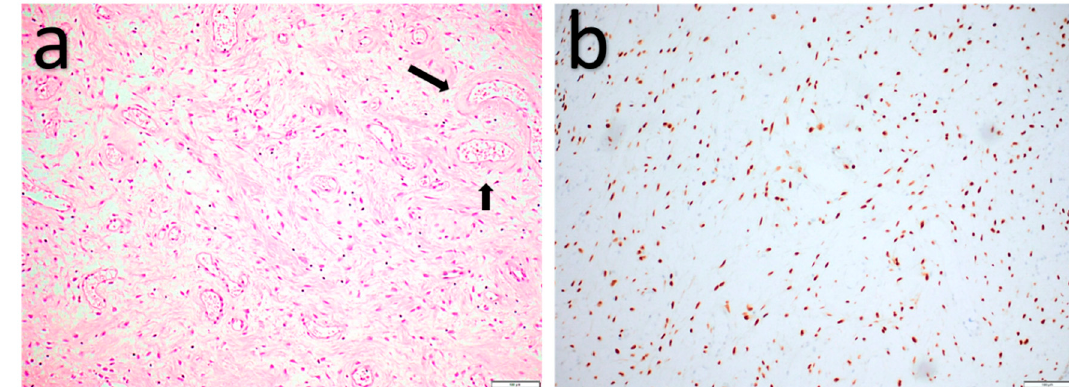
Figure 7. Cellular angiofibroma. ( a ) Bland spindle cells in a variably fibrous and hyalinized stroma with numerous hyalinized, small- to medium-sized vessels (arrows). ( b ) Strong, diffuse nuclear progesterone positivity.